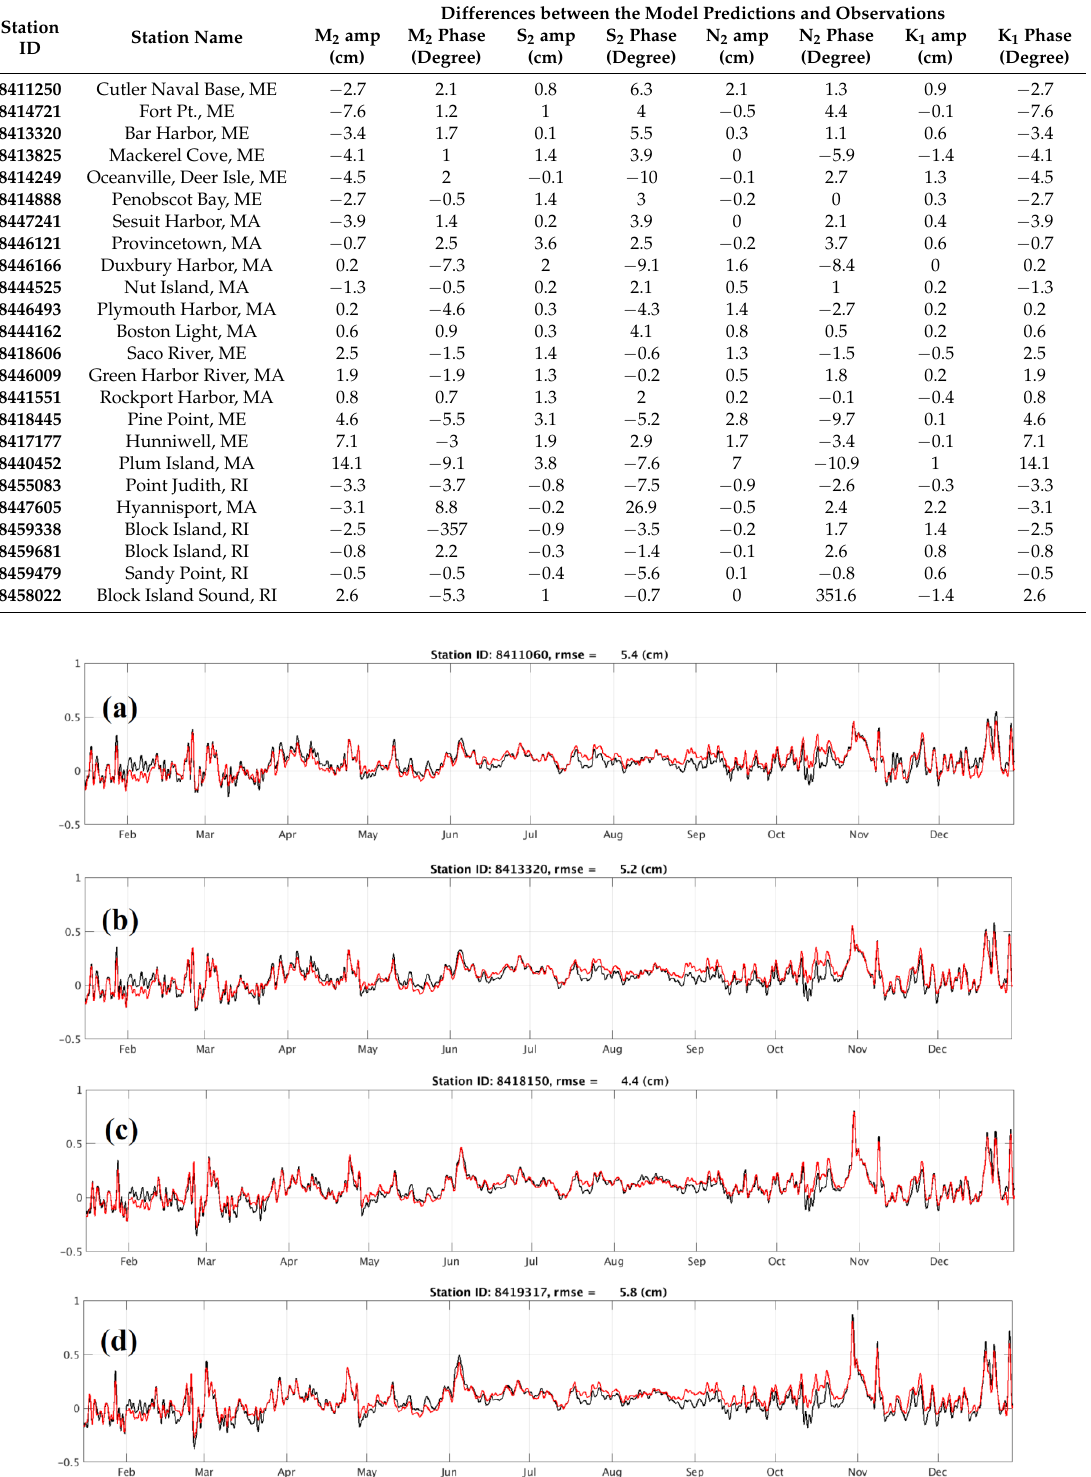
Table 2. The model-data comparison of harmonic constants for the M 2 , S 2 , N 2 , and K 1 constituents, respectively. The stations are listed in the order of the total tidal range ranking from the largest to the